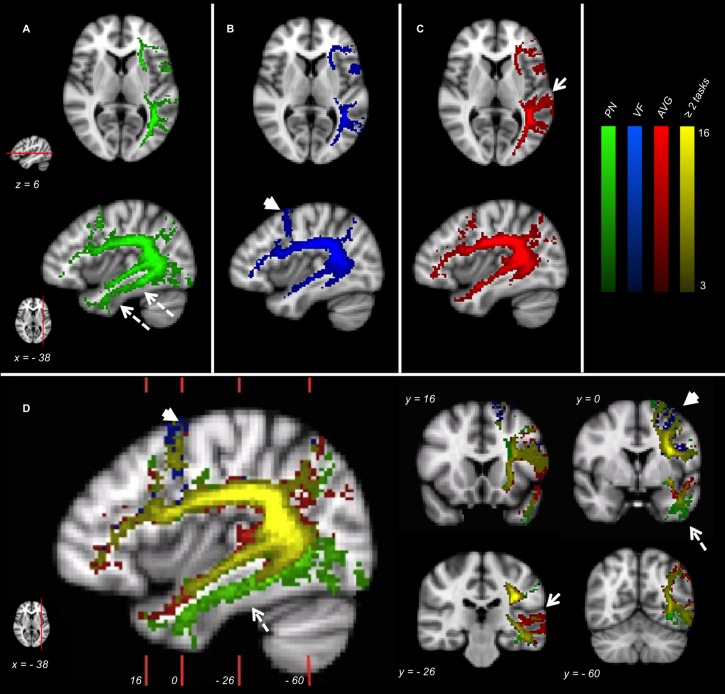
fMRI-targeted Tractography Atlases (group analysis) of 16 healthy controls. (A) PN; (B) VF; (C) AVG; (D) Different tasks overlayed. Only voxels represented in at least three subjects are displayed. Color brightness of each voxel is proportional to the number of subjects in whom the voxel was represented. The reference axial and parasagittal MNI slices (MNI z = 6, x = –38, respectively) are shown on the left side of the figure. The reference coronal MNI slices (MNI y = 16, 0, –26, –60) are shown on the parasagittal figure in (D).